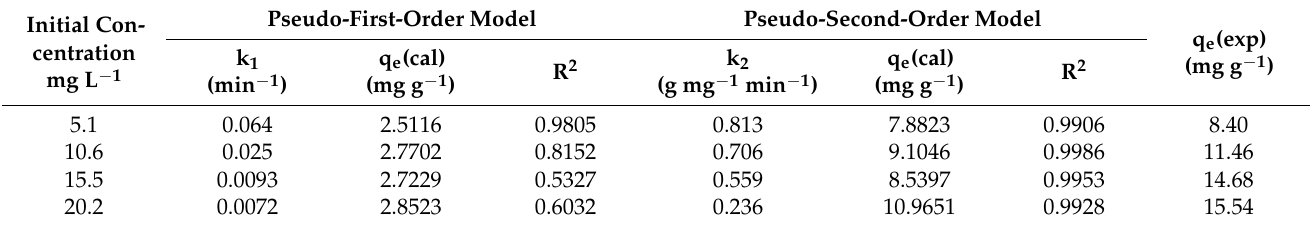
Table 2. Fitting parameter of the pseudo-first-order model and pseudo-second-order model for Cr(VI) reduction by